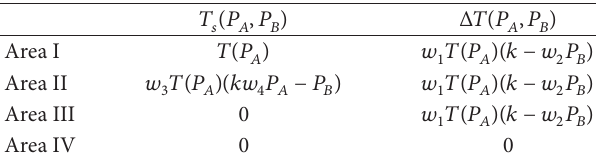
Figure 3: The change of 𝑇 𝑠 with the variety of 𝑃 𝐵 and 𝑃 𝐴 . Table 1: The table of area’s shift function and increment